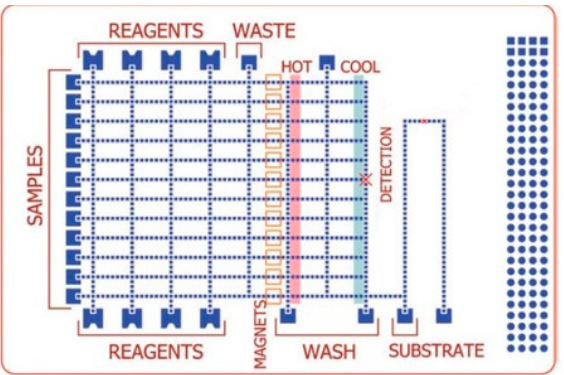
Figure 5. Schematic of the in-house fabricated DMF device for DNA amplification. Top glass plate included drilled ports for sample insertion/withdrawal, and both plates were spaced via a 185 µm polymer film. Adapted from original in reference [9].